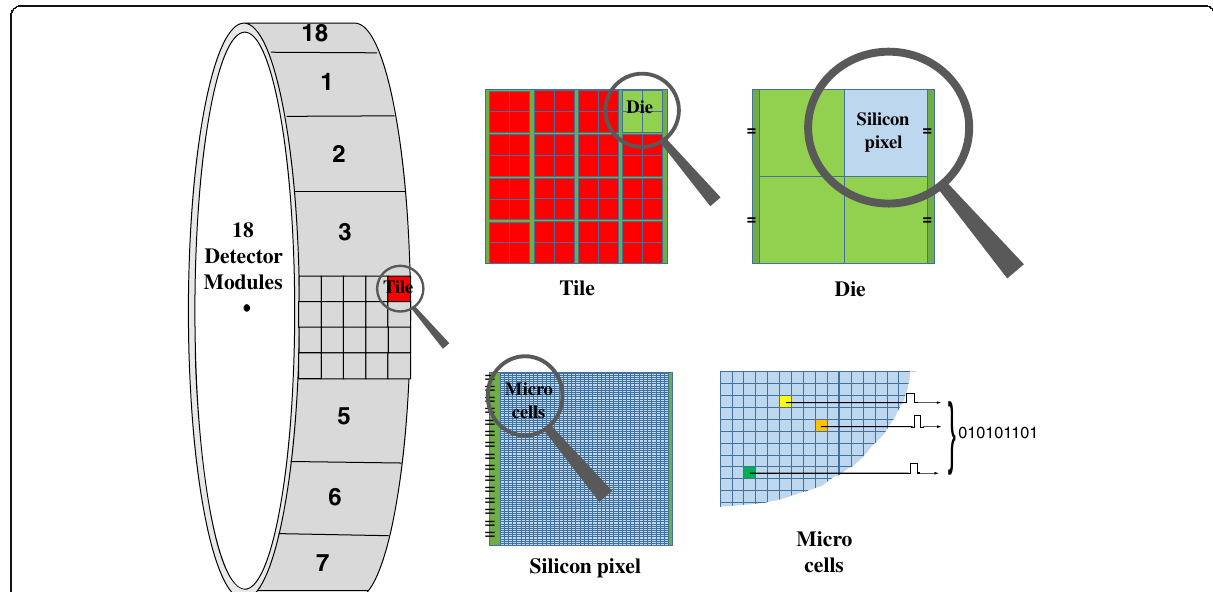
Fig. 1 Solid-state digital photon counting PET detector design. When a scintillation photon hits the microcell sensor, the integrated photon counter increases and the integrated timer measures the arrival time of the individual photon on that die. The chip measures all photons during the desired duration of the detection process. The values of the integrated photon counter and timer are read out via a digital